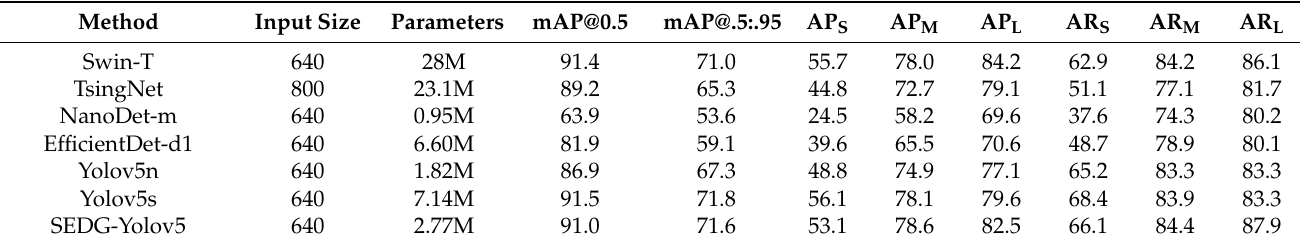
Table 2. Performance comparison with different detection models on the TT100K dataset